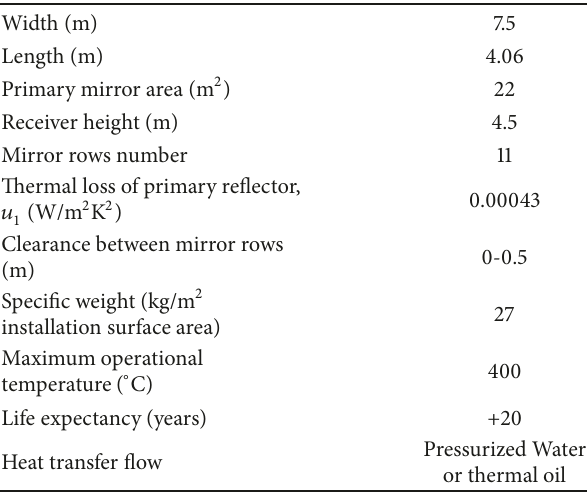
Table 1: Technical data of basic IS-LF11 module